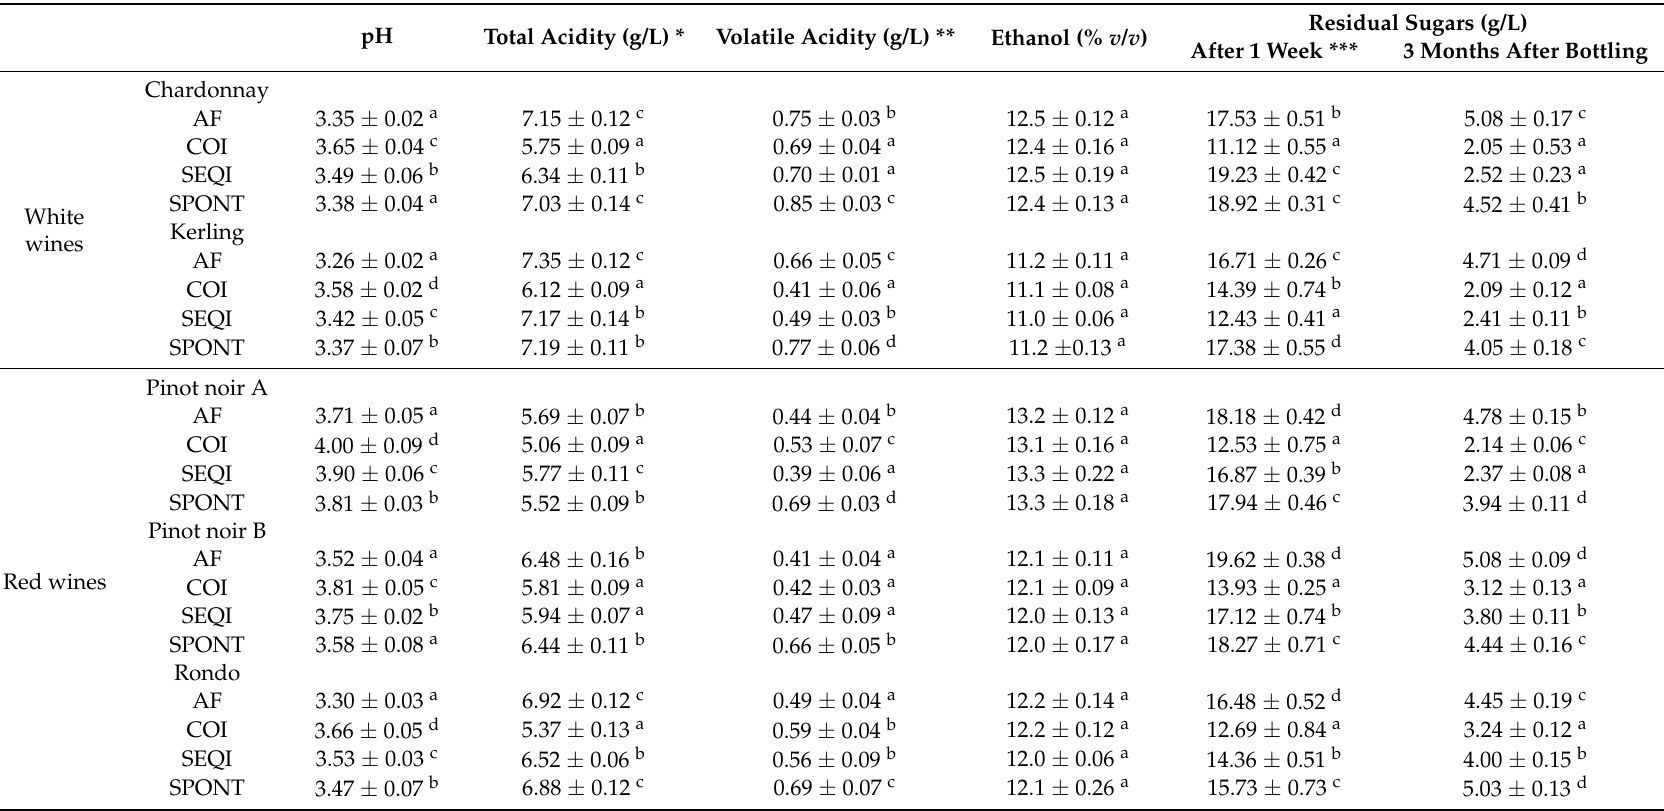
Table 1. Chemical characteristics of wines produced by different methods of MLF induction; parameters were evaluated three months after